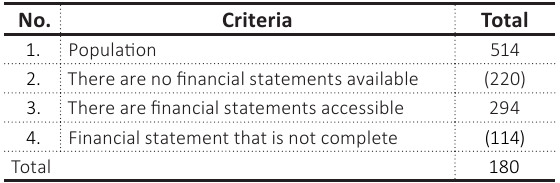
Table 1. Final sample